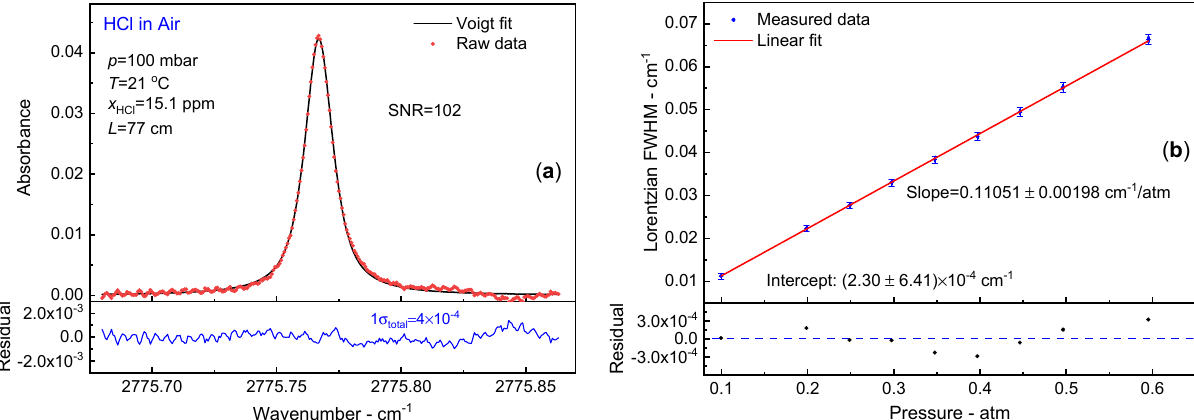
Figure 6. ( a ) Measured HCl absorption spectra in O 2 at 101.3 mbar and the fitting residual; ( b ) Measured O 2 induced pressure broadening with a linear fitting model. The residual between fit and data is shown below.